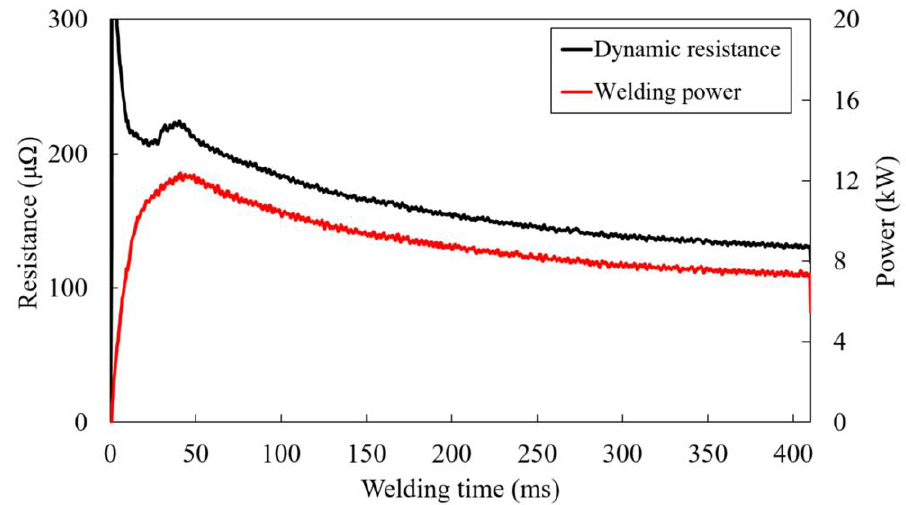
Figure 2. Dynamic resistance and welding power as a function of welding time.